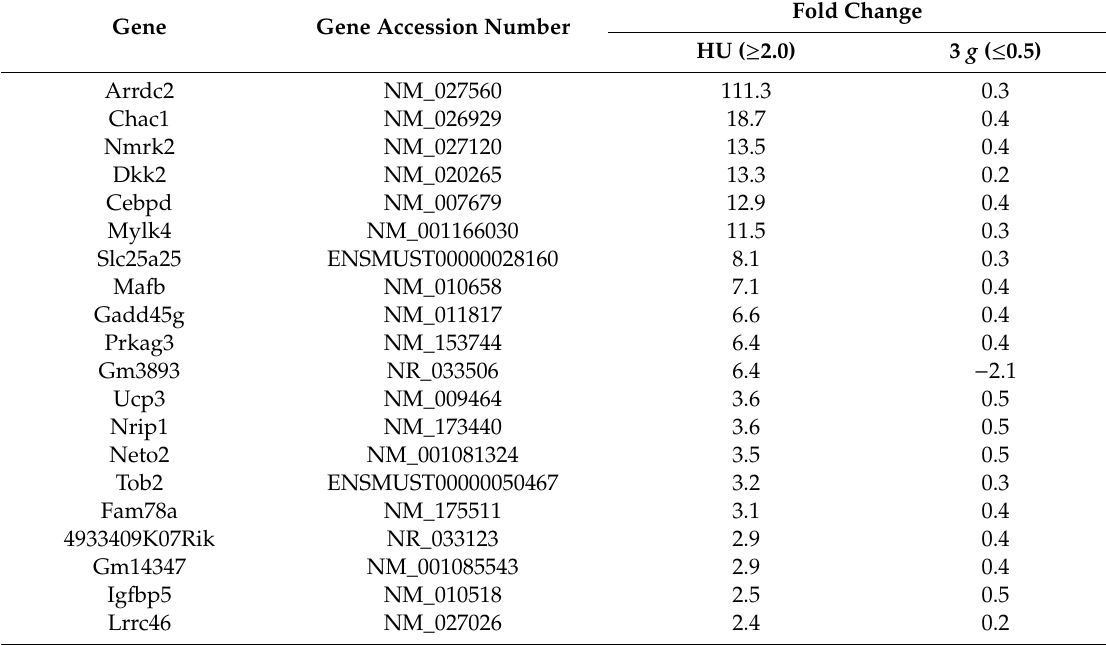
Table 1. Gene transcripts in the soleus muscle of mice with HU versus control mice as well as 3 g mice versus 1 g